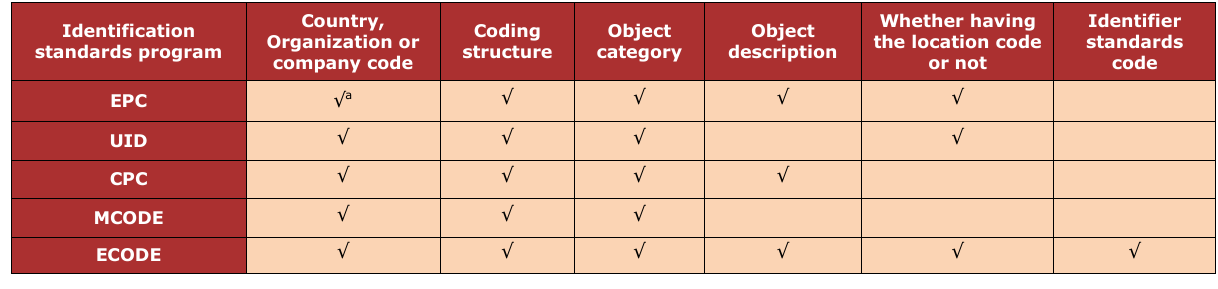
Table 2. Comparison Table of Objects Code and